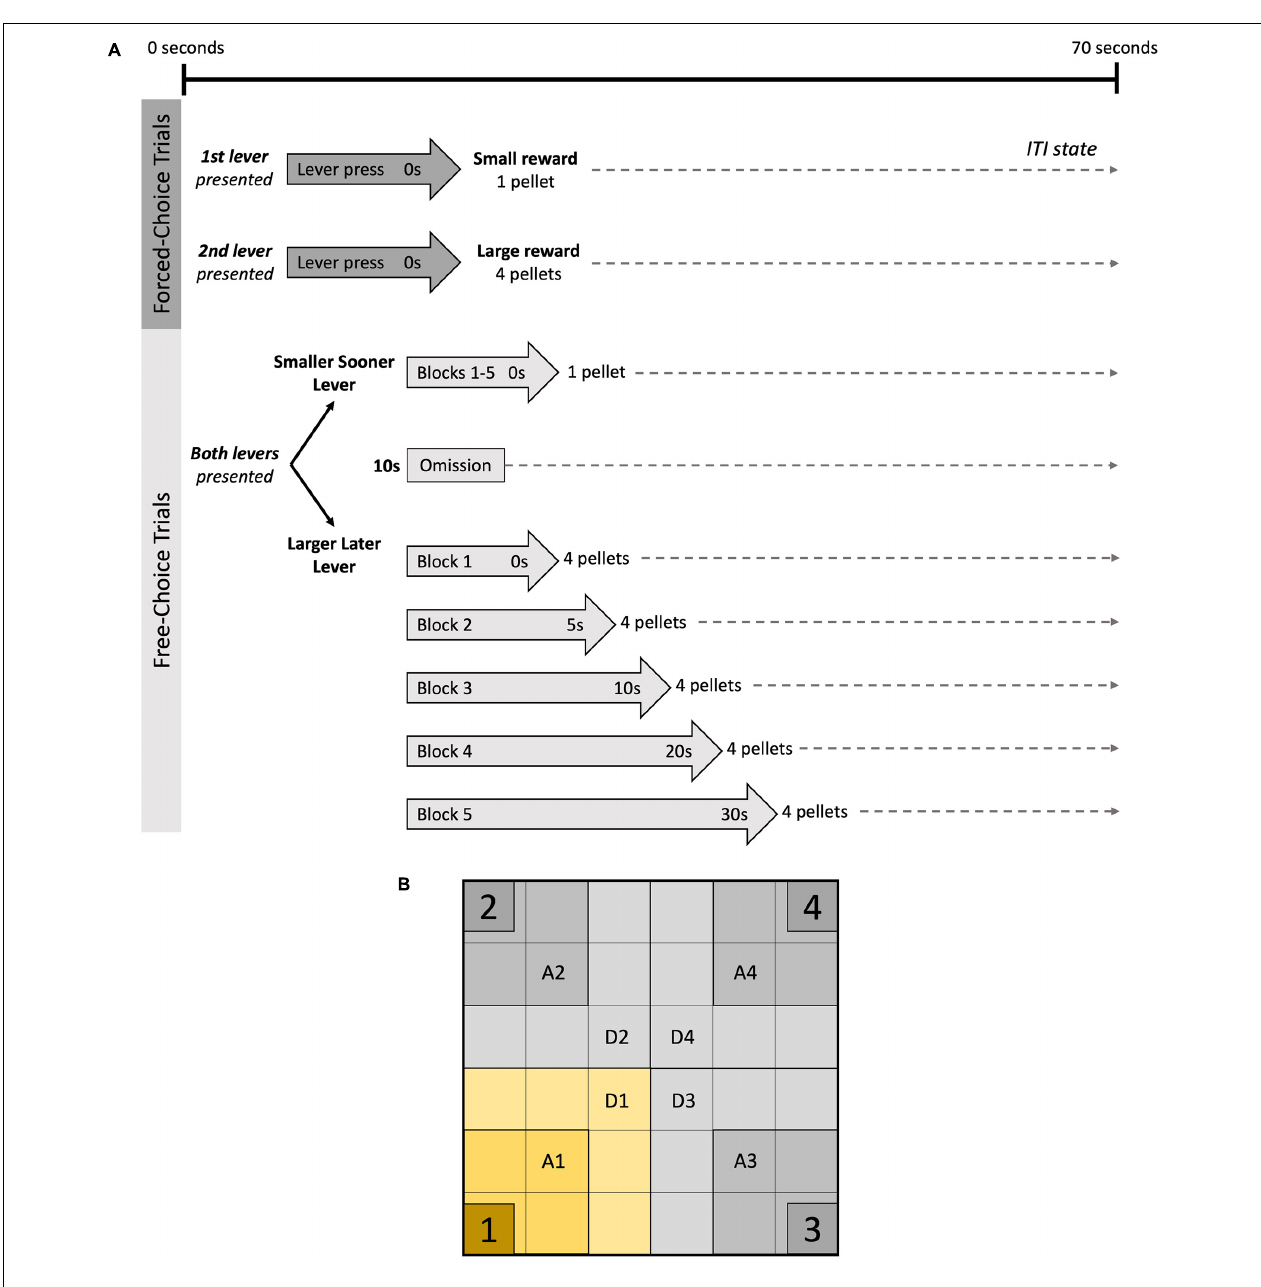
FIGURE 2 | DD task and PO arena. (A) Delay discounting (DD) task: each block consisted of two forced-choice trials, followed by 10 free-choice trails. During forced-choice trials, only one lever was presented at a time, and corresponding food reward was dispensed if lever was pressed within 10 s, followed by intertrial interval (ITI), during which both levers were retracted. In free-choice trials, both levers were presented. Lever press led to delivery of corresponding food reward (1 or 4 sucrose pellets), after which the ITI was initiated for the remainder of the trial. Delays for large reward increased after each block (0, 5, 10, 20, and 30 s). Failure to press a lever within 10 s was considered an omission and led to ITI. (B) Predator odour (PO) Test arena: for analysis, each quadrant was divided into zones which were adjacent (A1–A4) and distant (D1–D4) to the clear plastic containers placed in each corner. Container #1 held the bobcat urine.